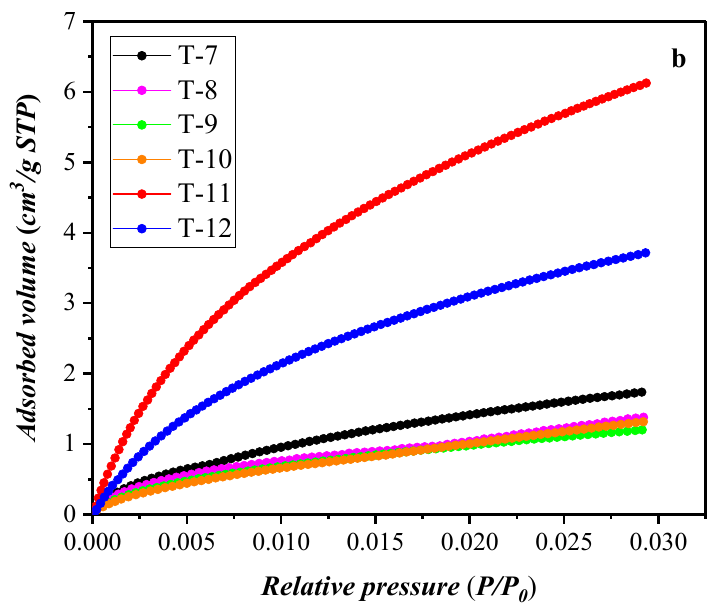
Figure 1. Carbon dioxide adsorption isotherms at 0 ◦ C for the 12 shale samples: ( a ) The first six shale samples, ( b ) The last six shale samples.